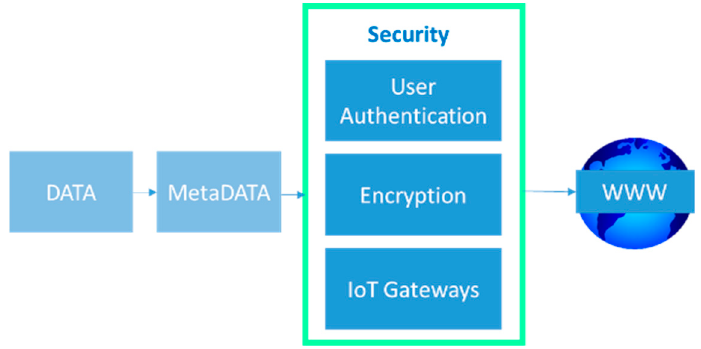
Figure 3. The security aspects of data safety.